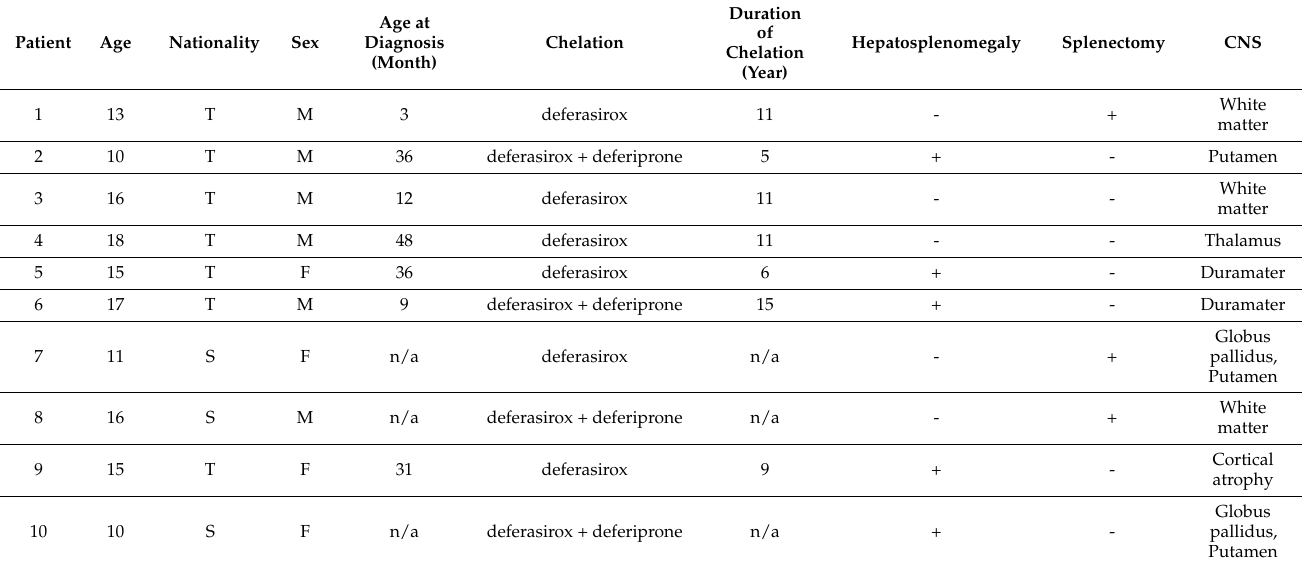
Table 3. Characteristics of patients with pathology on MRI.